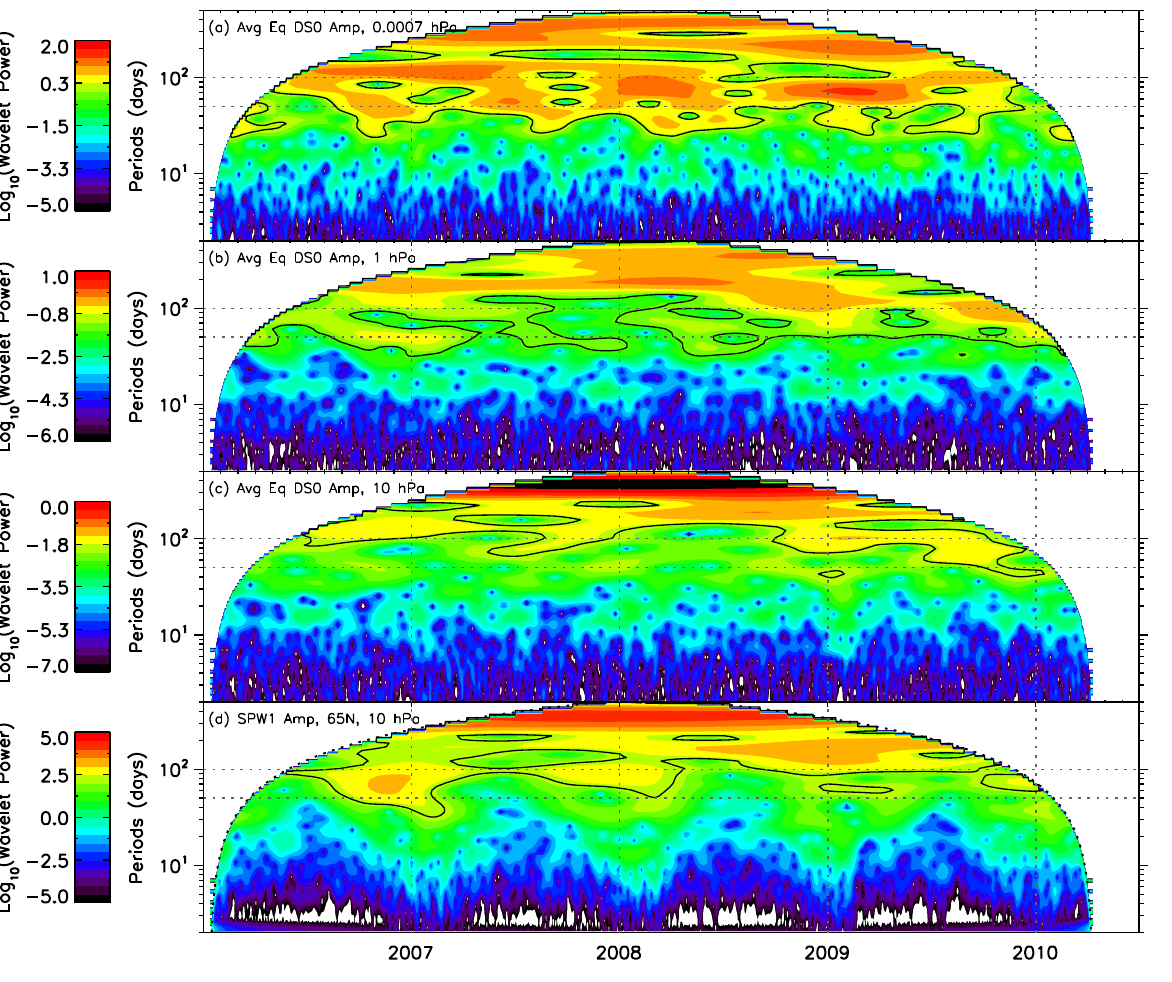
Figure 10. Wavelet power spectrum of average amplitude of DS0 over ± 20 ◦ at ( a ) 0.0007 hPa, ( b ) 1 hPa and ( c ) 10 hPa, ( d ) wavelet power spectrum of SPW1 amplitude over 65 ◦ N at 10 hPa extracted from CMAM30 temperature